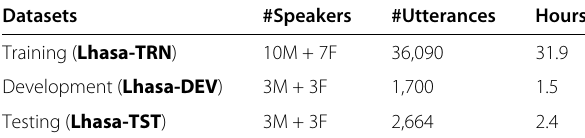
Table 1 Speech corpus of Lhasa